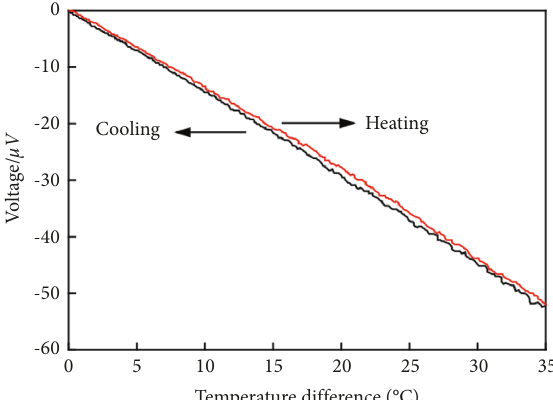
Figure 9: Short carbon fiber as the thermistor material to fill concrete [62].